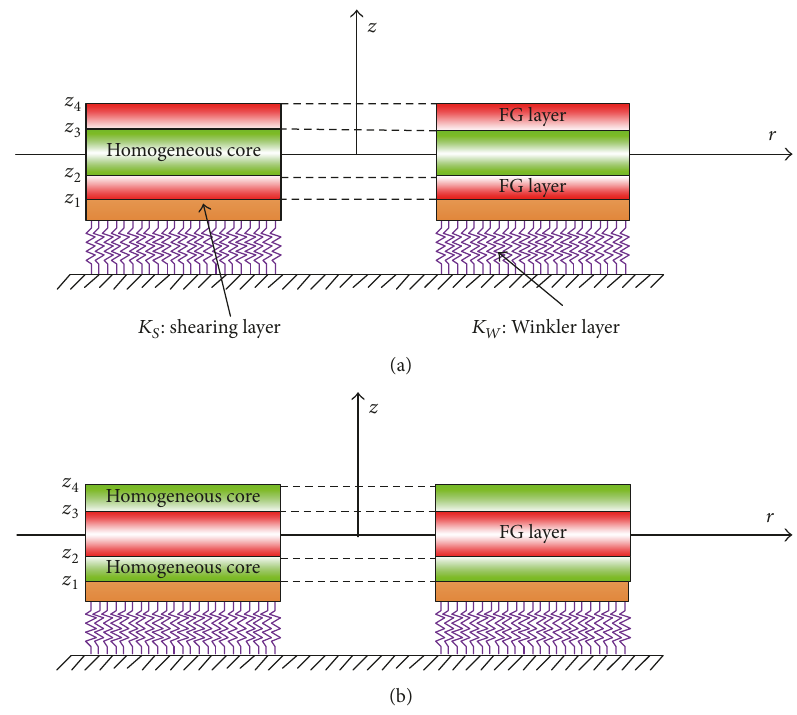
Figure 2: The material variation along the thickness of the FG sandwich annular sector plate: (a) FGM face sheet and homogeneous core; (b) homogeneous face sheet and FGM